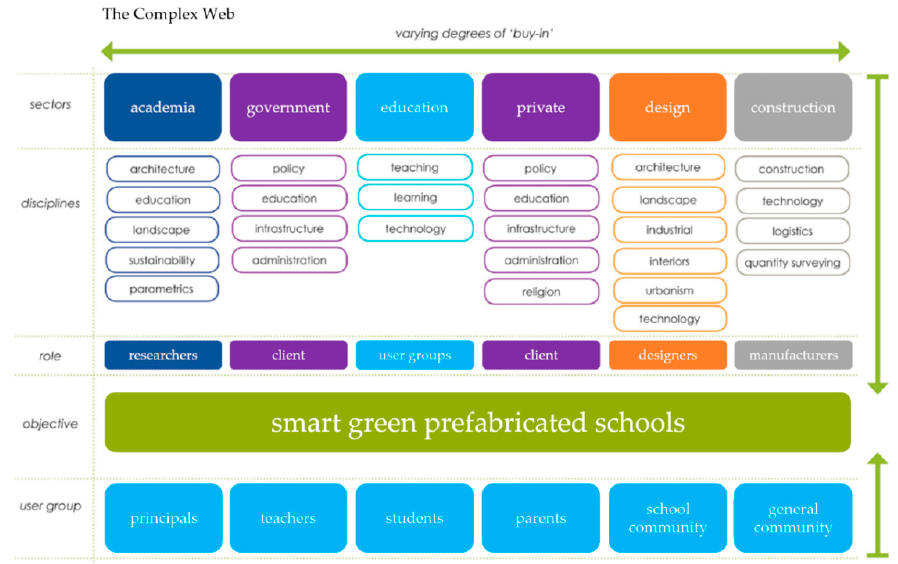
Figure 6. The Complex Web Image adapted by S.B from [13].